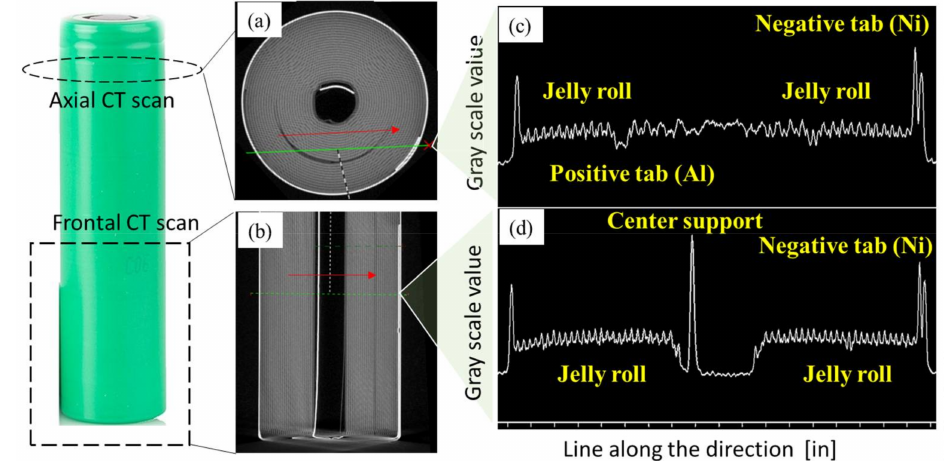
Figure 6. CT scan images of a cylindrical lithium-ion battery: ( a ) axial view; ( b ) front view; ( c ) gray-scale values for the line in the axial view; ( d ) gray-scale values for the line in the front